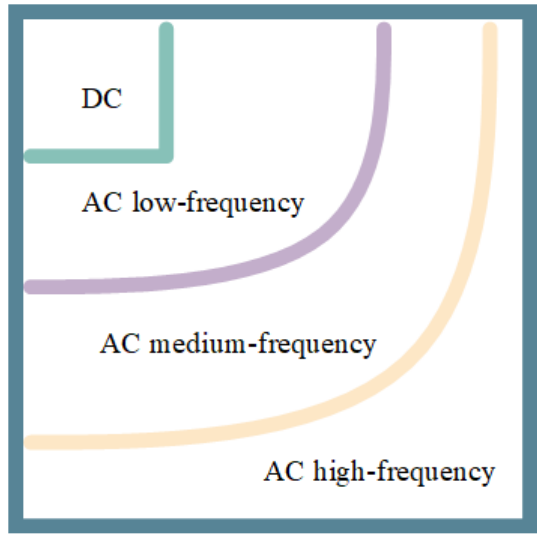
Figure 2. DCT coefficient frequency distribution diagram.